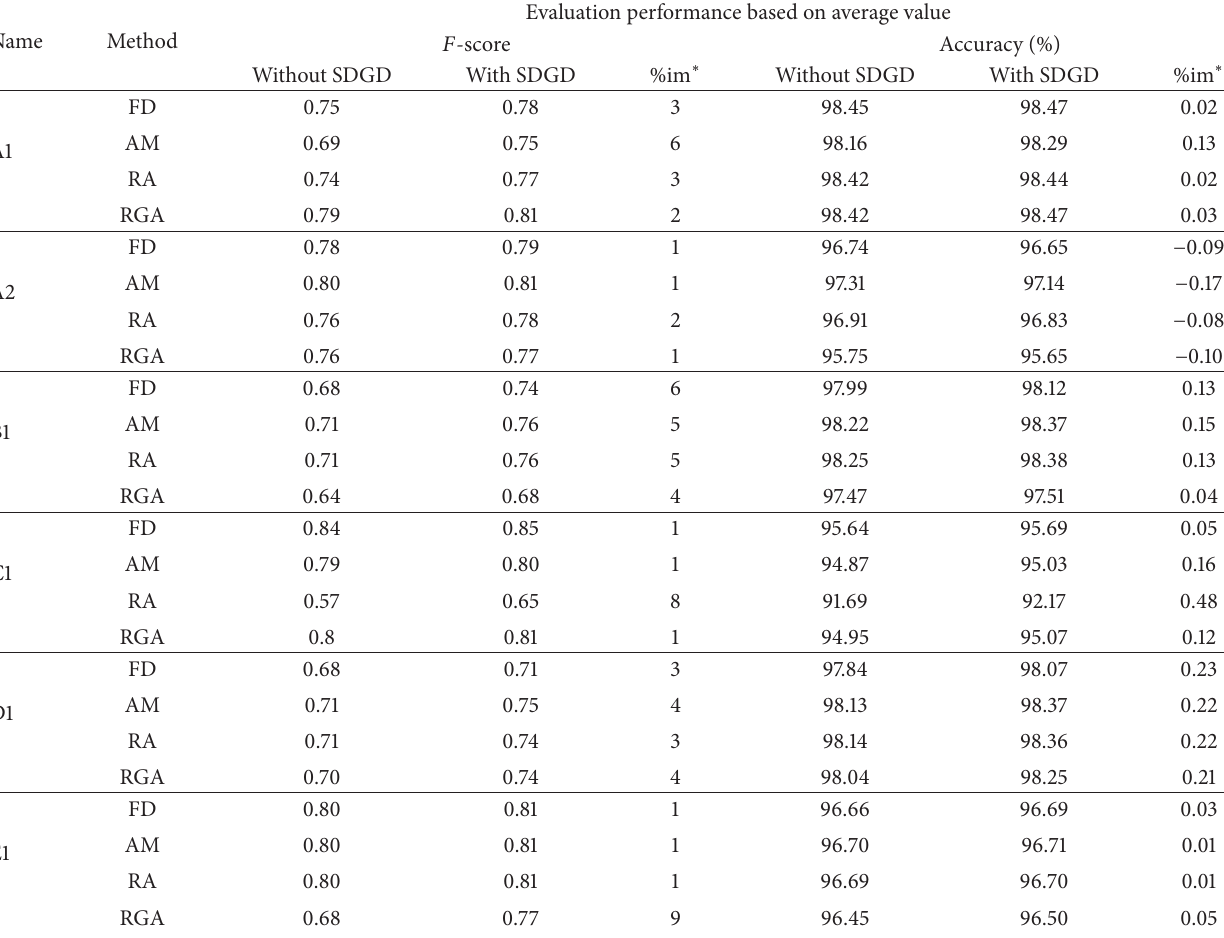
Table 3: Performance of each technique.